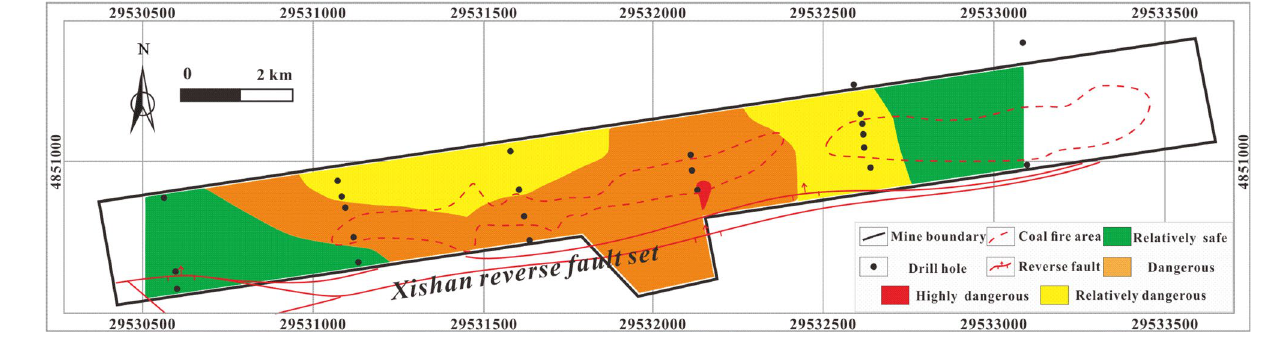
Figure 10. Thematic map of CH 4 concentration in MAPGIS